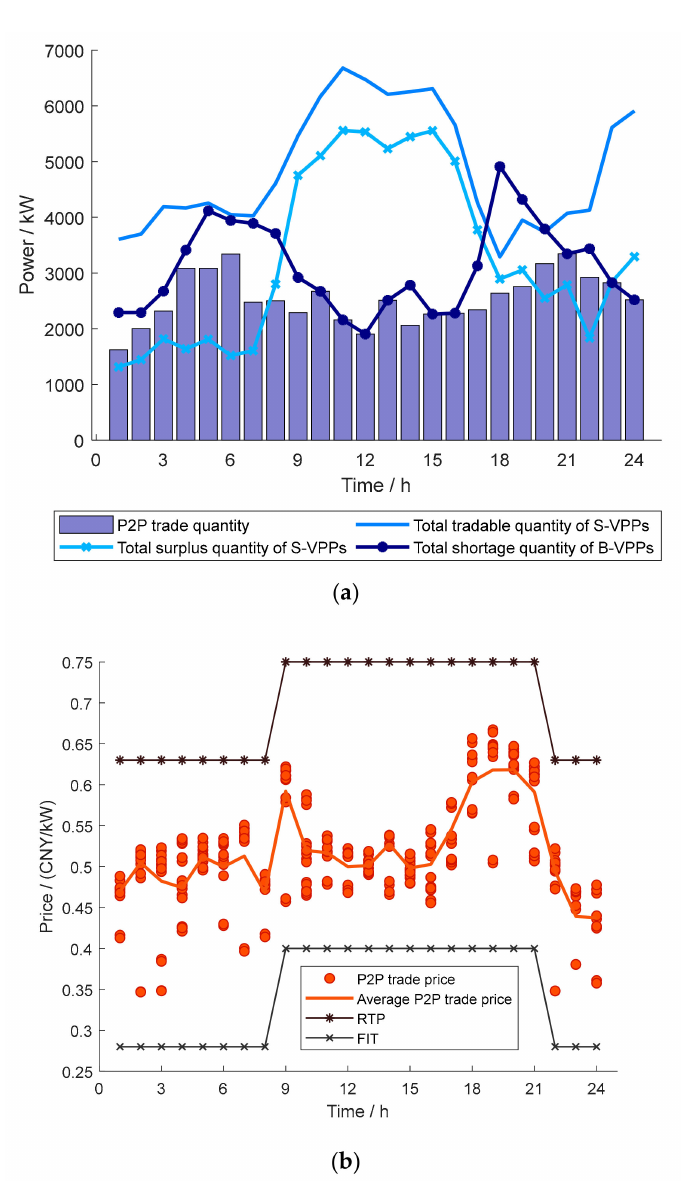
Figure 8. ( a ) Various quantities varying with time; ( b ) trade prices of matched orders in the first round of P2P negotiation (R =